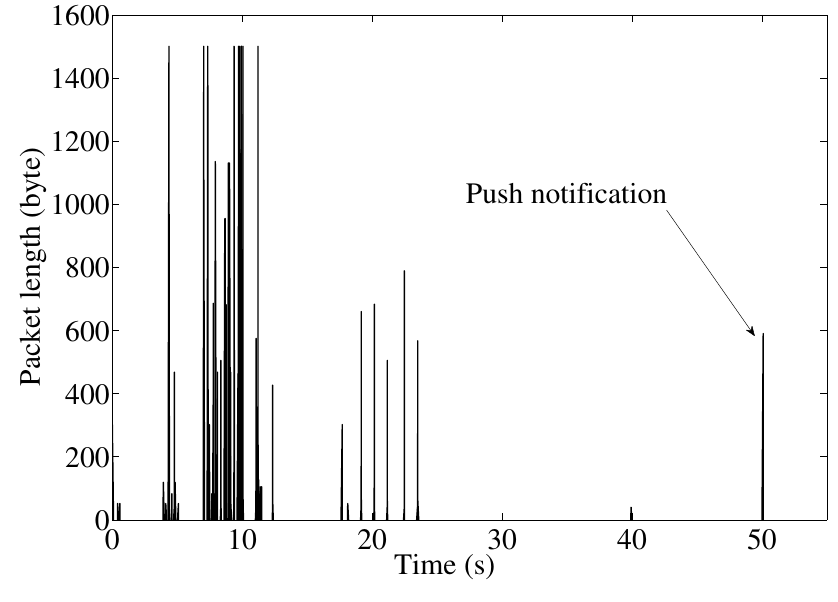
Figure 6. iPhone trace: the push notification is the last spike. The inability to separate Facebook push notifications from other app notifications makes recognition harder than with